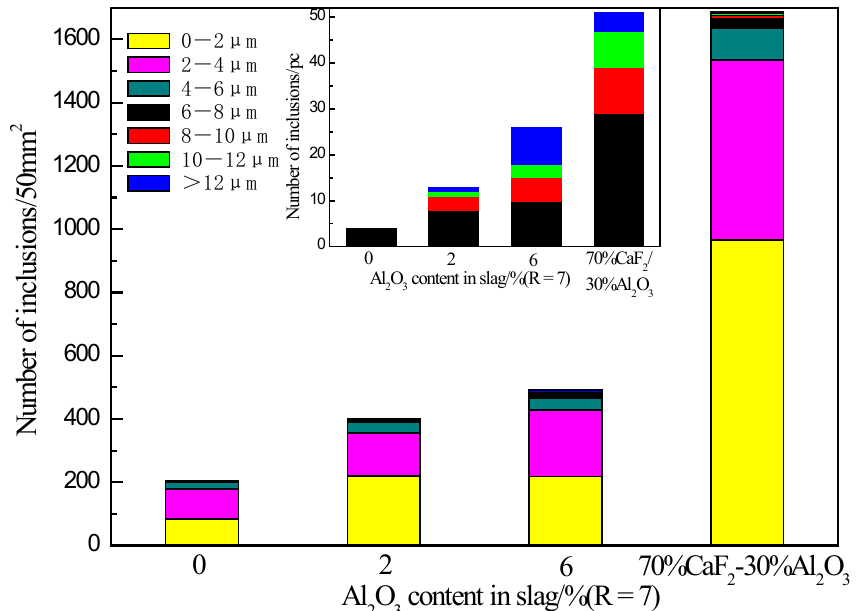
Figure 10. Effect of Al 2 O 3 content in the slag on the number of inclusions with different diameter. It can be seen from Figure 10 that 204 inclusions were detected in the electroslag ingot when Al 2 O 3 -free slag was used for remelting. When the Al 2 O 3 content in the slag increased to 2% and 6%, the number of inclusions increased to 402 and 491, respectively. When the Al 2 O 3 content was 30%, the number of inclusions increased sharply to 1687, which was consistent with the change in oxygen content shown in Figure 3b.